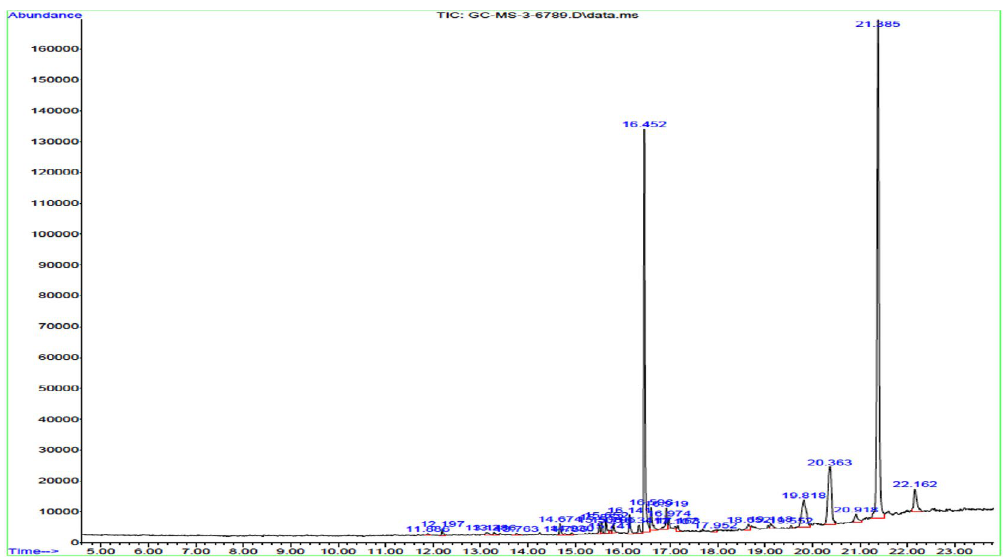
Fig. 7. Shows the GC-MS spectrum of Penicillium sp. MIP-3 extract. Table 1. lists the major compounds observed in the GC-MS spectrum of Penicillium sp. MIP-3 extract